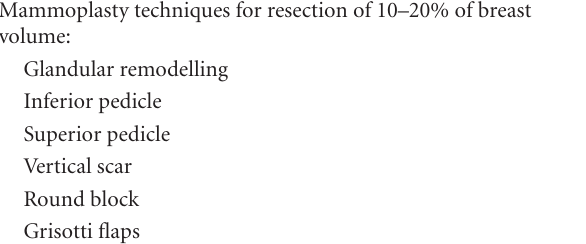
Mammoplasty techniques for resection of 10–20% of